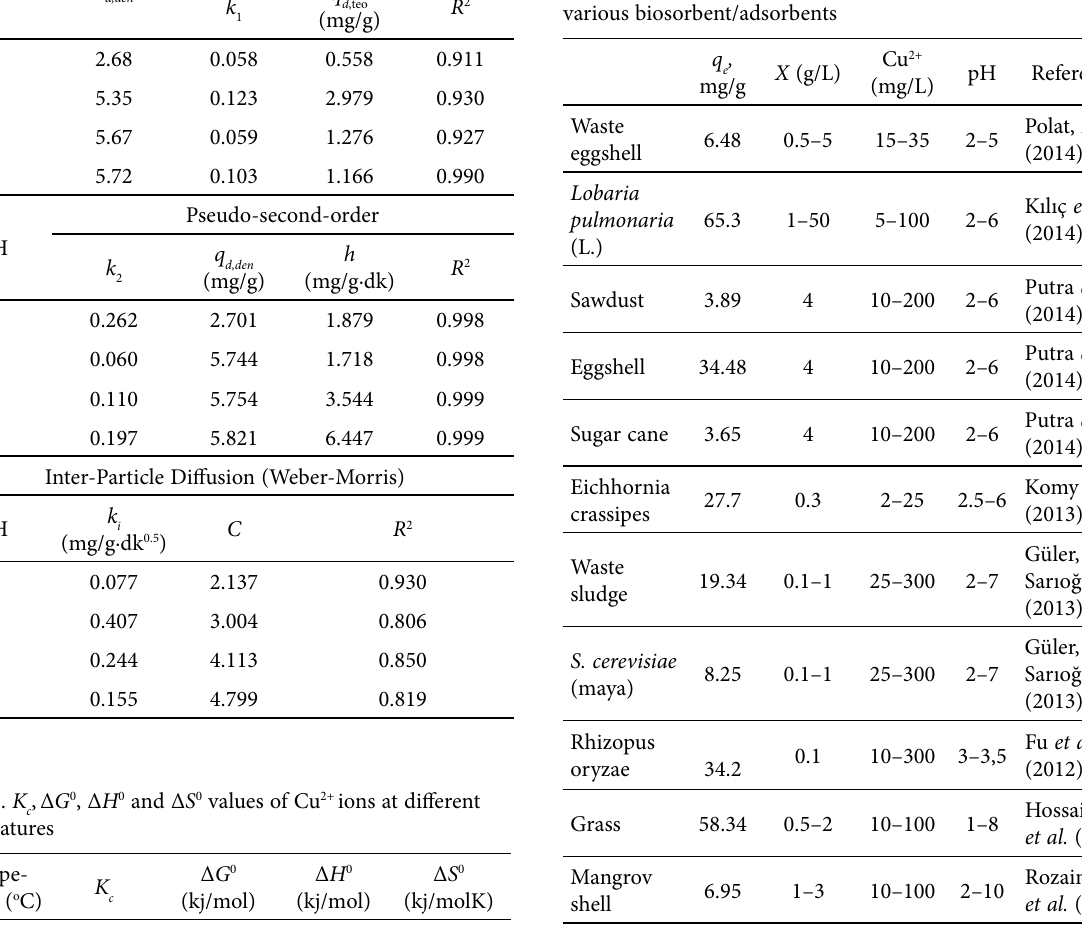
Fig. 11. Van t’Hoff graph of Cu 2+ biosorption for Table 4. Comparison of biosorption studies carried out